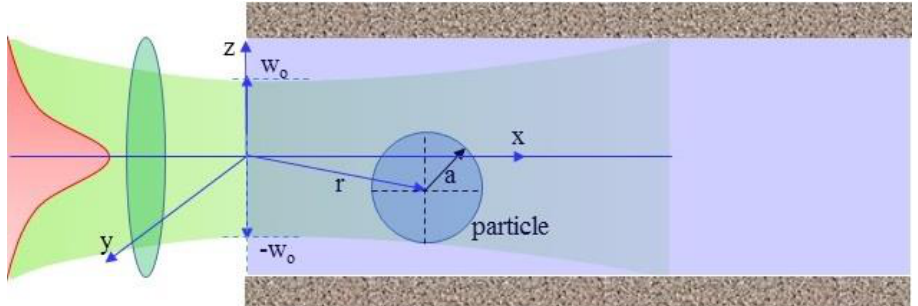
Figure 2. Representation of the interaction between a Gaussian continuous laser beam and a nanofluid in a micro-channel. The laser beam is slightly focused using a focusing lens, w o is half of the beam waist which is at the channel entrance ( x = 0), a is the particle radius, r is the location of the particle relative to center of the beam waist.